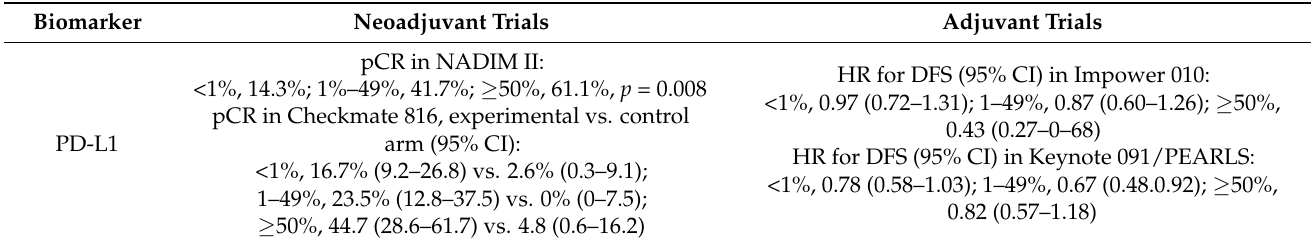
Table 5. PD-L1 as biomarker for perioperative immunotherapy in NSCLC. Biomarker Neoadjuvant Trials Adjuvant